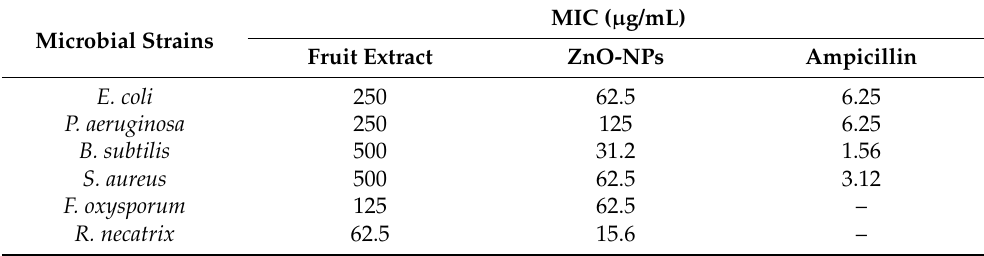
Table 2. MIC of fruit extract and ZnO-NPs against bacterial and fungal